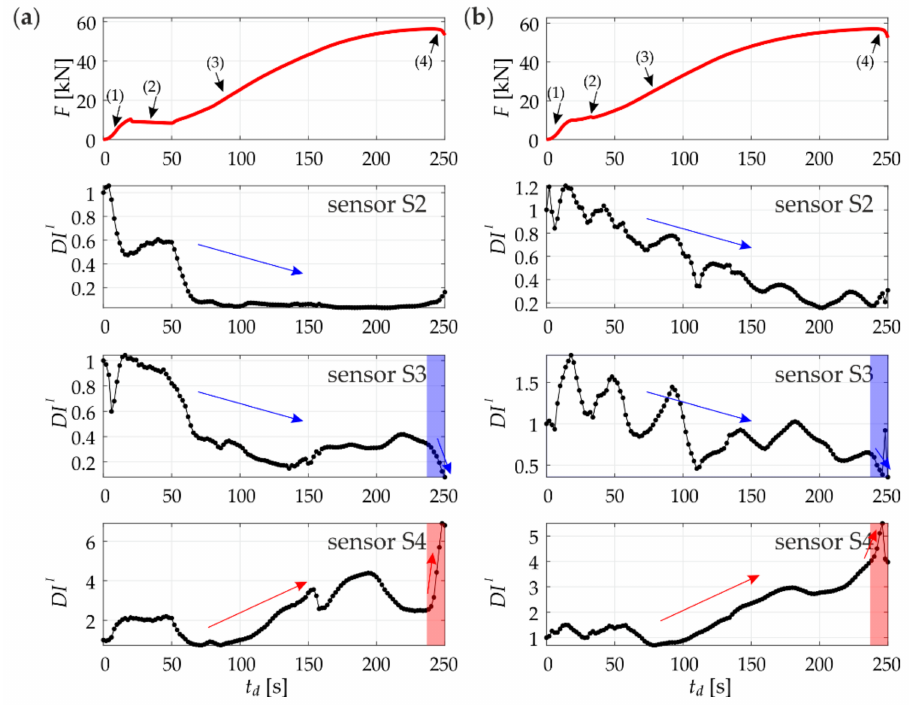
Figure 8. Damage index DI I for guided waves registered by sensors S2, S3, and S4 during tensile testing: ( a ) specimen #1; and ( b ) specimen